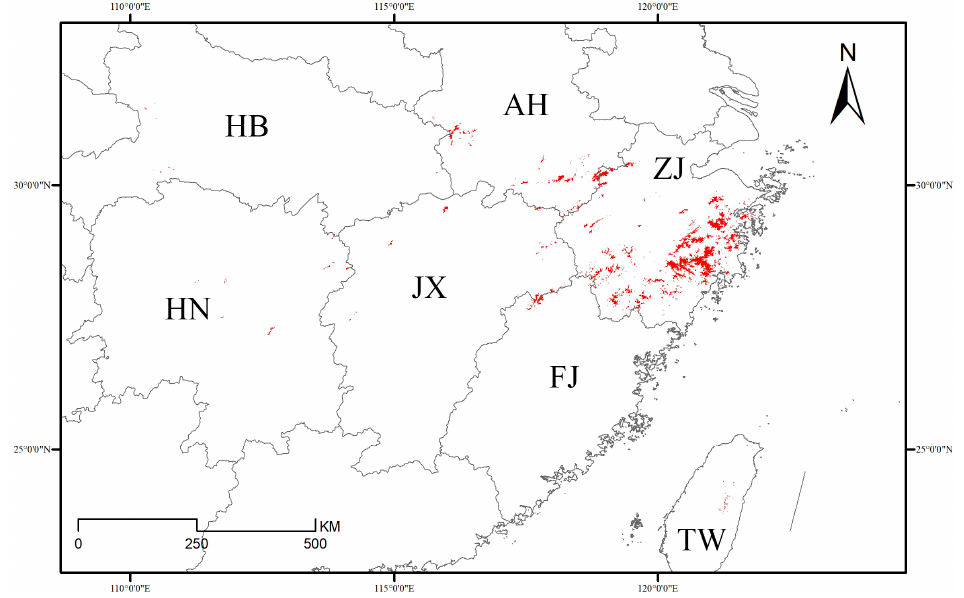
Figure 7. Suitable distribution areas of Carpinus tientaiensis in current and future scenarios. The red area indicates locations where the current, 2050s and 2070s climate scenarios are all suitable for C. tientaiensis .